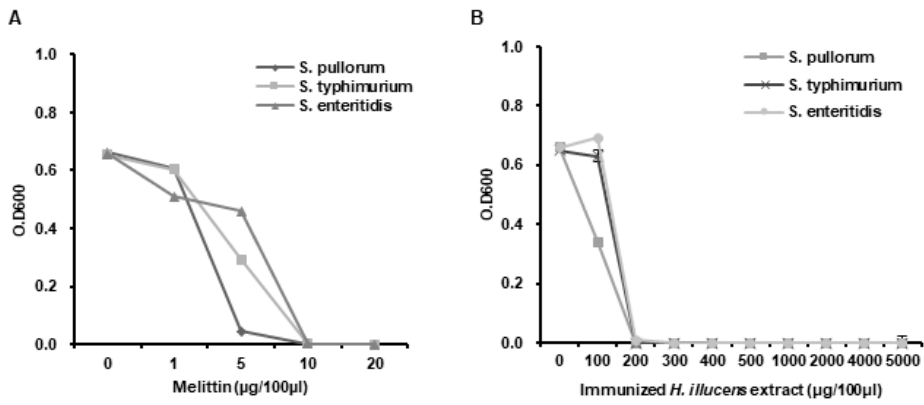
Figure 5. Antimicrobial activities of L. casei -immunized HIL extract against S. enteritidis , S. typhimurium and S. pullorum . Various concentrations of 10 µL melittin ( A ) or 10 µL L. casei -immunized and S. pullorum . Various concentrations of 10 µ L melittin ( A ) or 10 µ L L. casei -immunized HIL extract HIL extract ( B ) were mixed with 90 µL of liquid media containing 1 × 10 6 cfu/mL of S. enteritidis , S. ( B ) were mixed with 90 µ L of liquid media containing 1 × 10 6 cfu / mL of S. enteritidis , S. typhimurium , typhimurium , or S. pullorum and incubated at 37 °C for 24 h. or S. pullorum and incubated at 37 ◦ C for 24